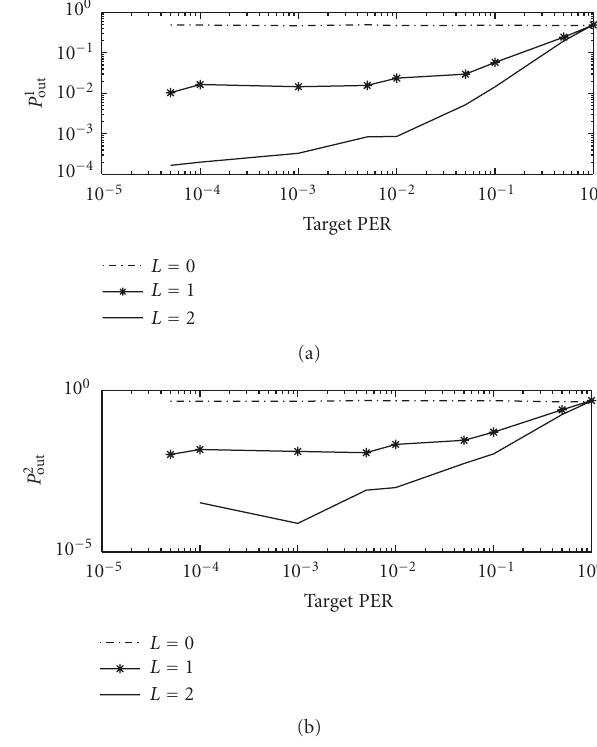
Figure 9: GMDP-based AC polices: outage probability as a function of target PER in which ρ